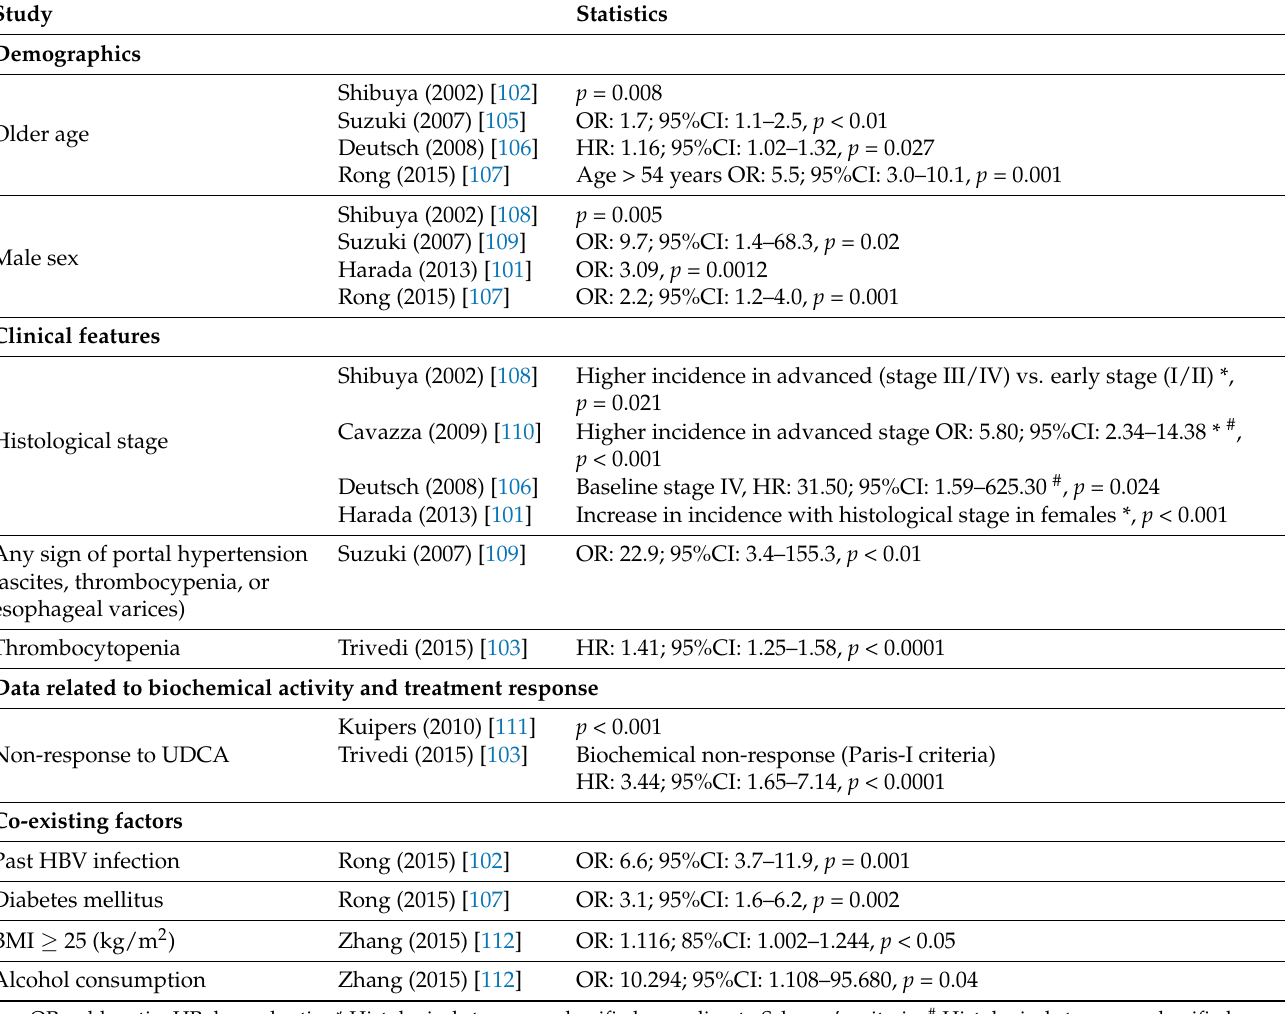
Table 3. Risk factors for hepatocellular carcinoma in patients with primary biliary